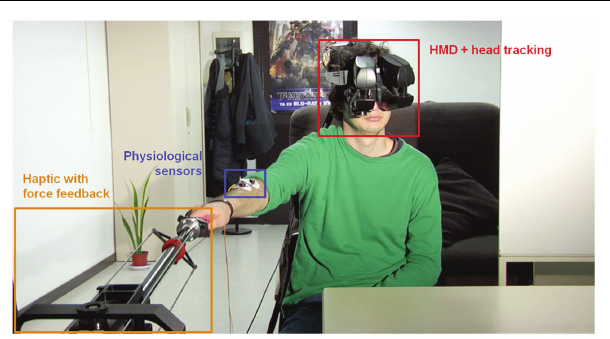
FIGURE 1 | Set-up at the patient’s home. The patient wears a HMD with head-tracking for immersion in the virtual environment from a first-person perspective of the avatar representing him.Wireless body tracking allows control over the avatar’s movements. A haptic device with force-feedback is used for tactile interaction with the environment and/or remote persons. Finally, several sensors and electrodes are attached to the patient to monitor his physiological and emotional